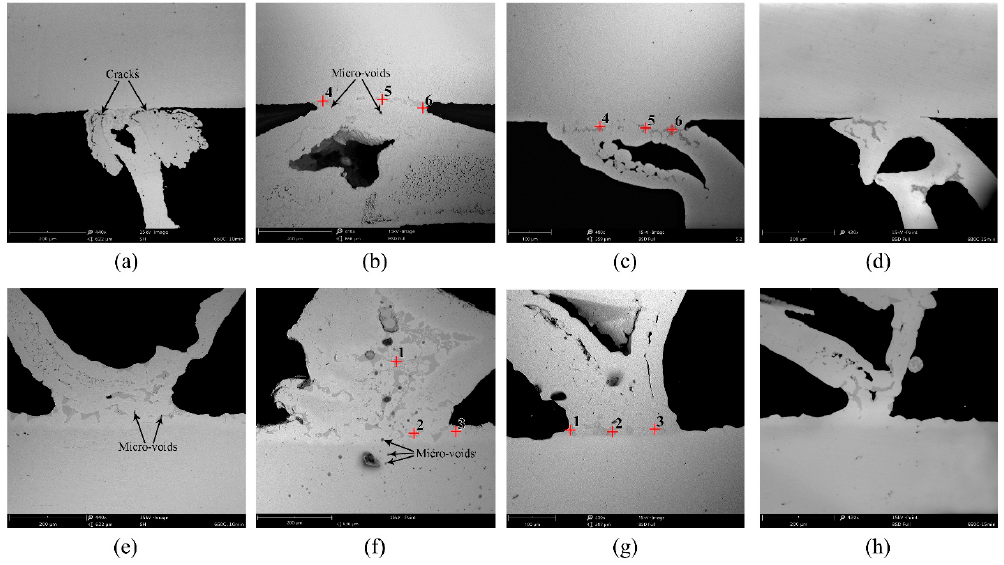
Figure 3. SEM images of brazed joints: ( a ) the name and location of manufacturer and ( e ) 660 °C, 10 ( d , h ) 680 ◦ C, 15 min. Images ( a–d ) represent the top side and ( e–h ) the base min; ( b , f ) 660 °C, 15 min; ( c , g ) 680 °C, 10 min; ( d , h ) 680 °C, 15 min. Images ( a–d ) represent the top side and ( e–h ) the base side.